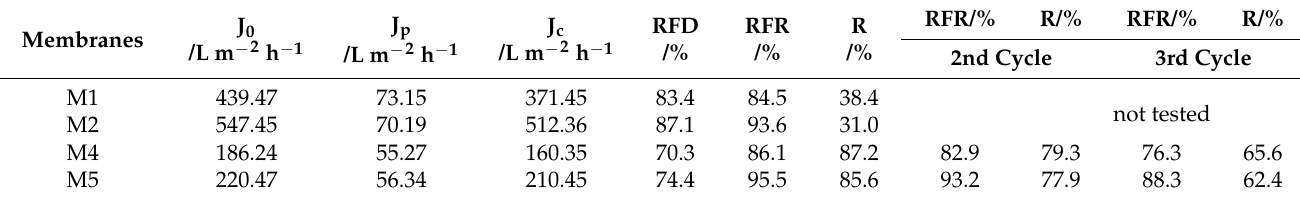
Table 3. Parameters in the filtration of BSA